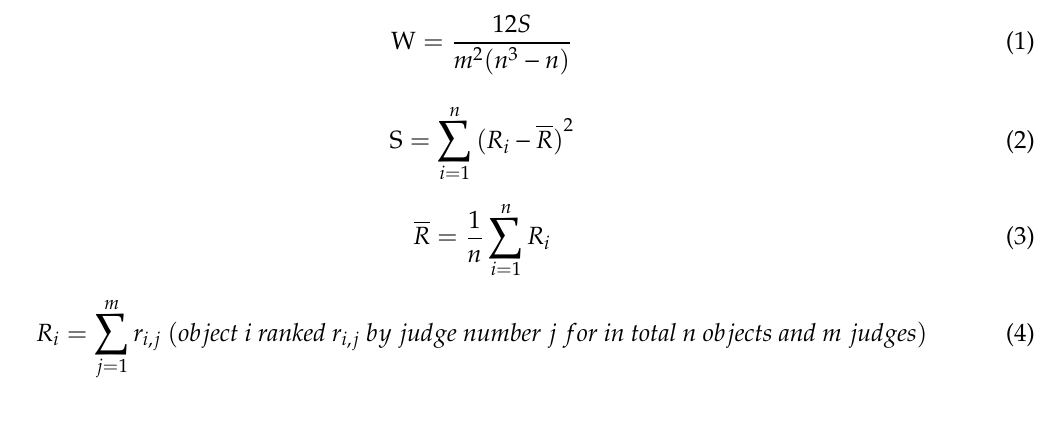
Table 5. Principal source selection criteria presented to the Delphi panel as